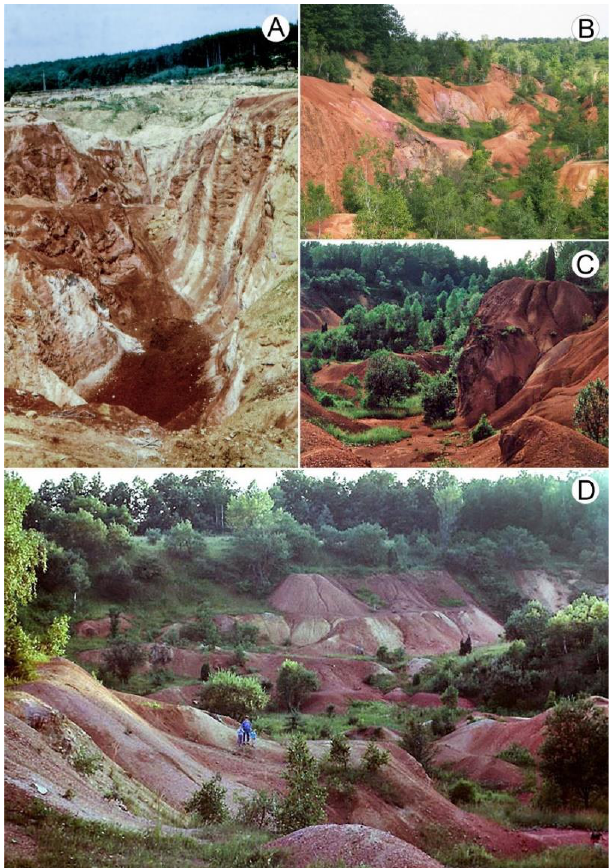
Figure 5. Surface depressions exhumed during bauxite mining that developed Upper Triassic Main Dolomite: ( A ) Iharkút, ( B – D ) Lake Darvas (own figure). The separation of the manganese ore of Ú rkút from mining waste was carried out in the manganese washing plant. The so-formed manganese mud led into one of the depres- sions of Kab Mountain. The sludge appeared in the spring of the valley located 1.5 km away from this site about three weeks later [21]. The sludge was led into the doline at a rate of 1 m 3 /min, which had an annual quantity of 0.5 million km 3 [21], although the du- ration of supply is unknown. Dolomite rubble beds are mined on dolomite at several places between the settlement of Márkó and Várpalota in the mountains. The thickness of the rubble ranges from some meters to several ten meters. According to [20], its thickness may also exceed 50 m at Nyirád. The reason for rubble formation is that the calcareous material sticking to dolo- mite crystals is dissolved, and the dolomite falls into parts [3]. At sites of rubble exploita- tion, the wavy surface of lower karstic bedrock dolomite is exposed. Inside strip pits, where the rock underwent rubble formation to a lesser degree, the rock was left, and thus, the strip pits are dissected by mounds. Several caves have been exposed during limestone mining. The longest is the recently discovered several km-long Hárskút Cave, which opens in the quarry of the Kőrisgyörgy Hill. The opened-up caves do not exist for a long time; they become shorter and then decay (e.g., in the quarry of Sümeg). There was mining activity on the sandstone fields of the Kál Basin. The Pannonian sand became cemented with the amorphous silica that had precipitated from the hot water of post-volcanic activity [22] on which a rich karren landscape developed [23]. In the area